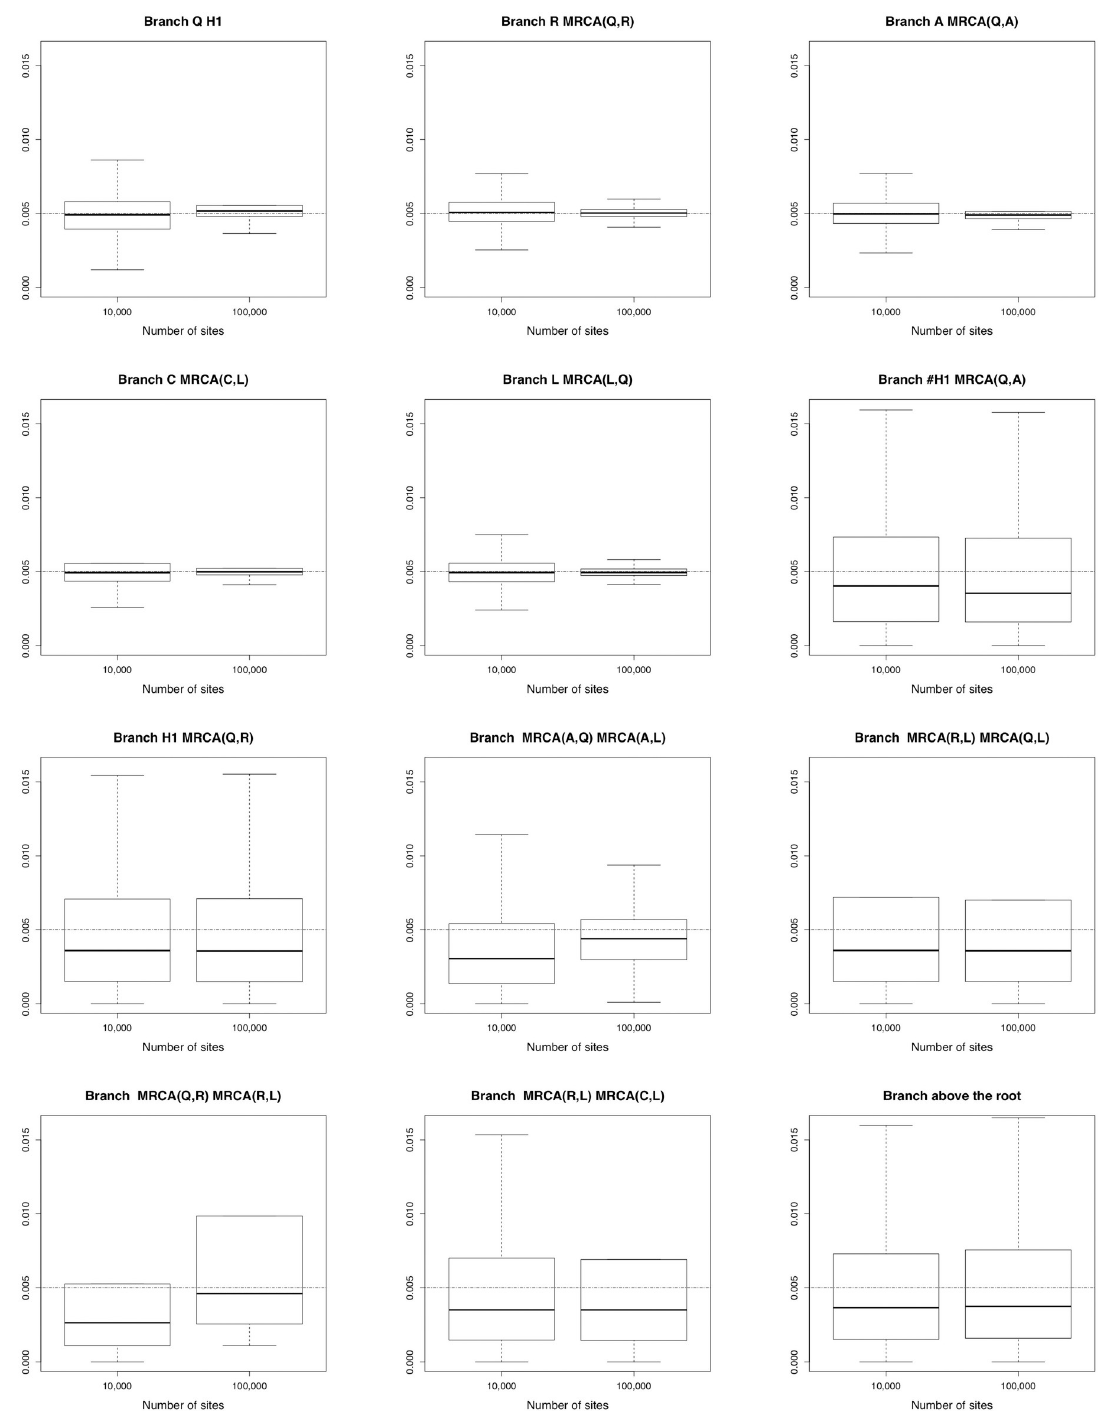
Fig 13. Estimated population sizes θ for each branch of network A (see Fig 7), as a function of the number of sites. True values are given by the dashed horizontal lines. Same framework as in Fig 10. The initials MRCA stand for “Most Recent Common Ancestor”.